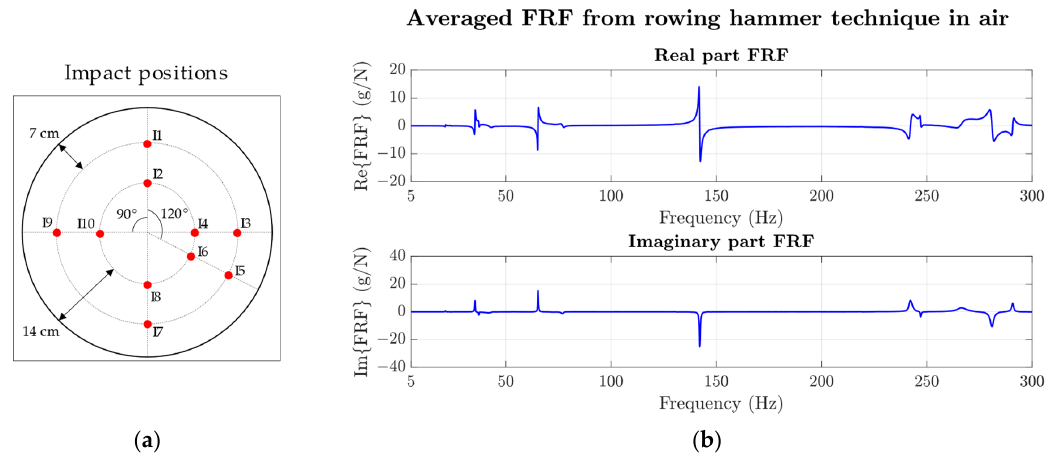
Figure 5. ( a ) Scheme of the impact positions on the disk excited using the instrumented hammer and ( b ) the real and imaginary parts of the averaged FRF between the on-board accelerometer and the hammer signals.